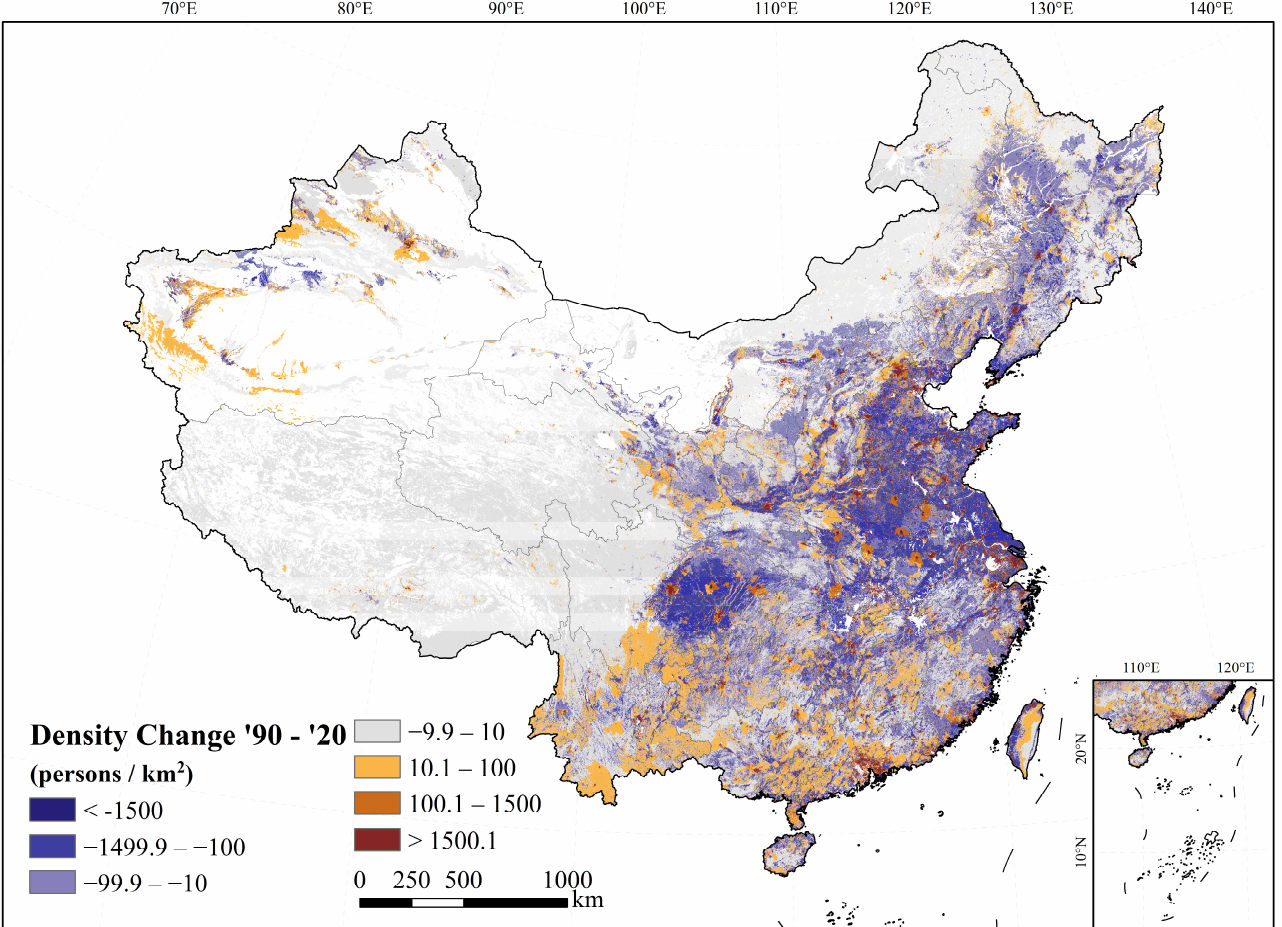
Figure 9. Changes in population density in China during 1990–2020. From 1990 to 2020, the percentage of the country’s people living in high-density areas went from 26% to 53.5% (Table 4). In contrast, the share of the population located in mid- and low-density regions decreased by 9% and 47%, respectively. From 1990 to 2020, for every 1 km 2 increase in high-density areas, 29.4 km 2 of the area was depopulated on